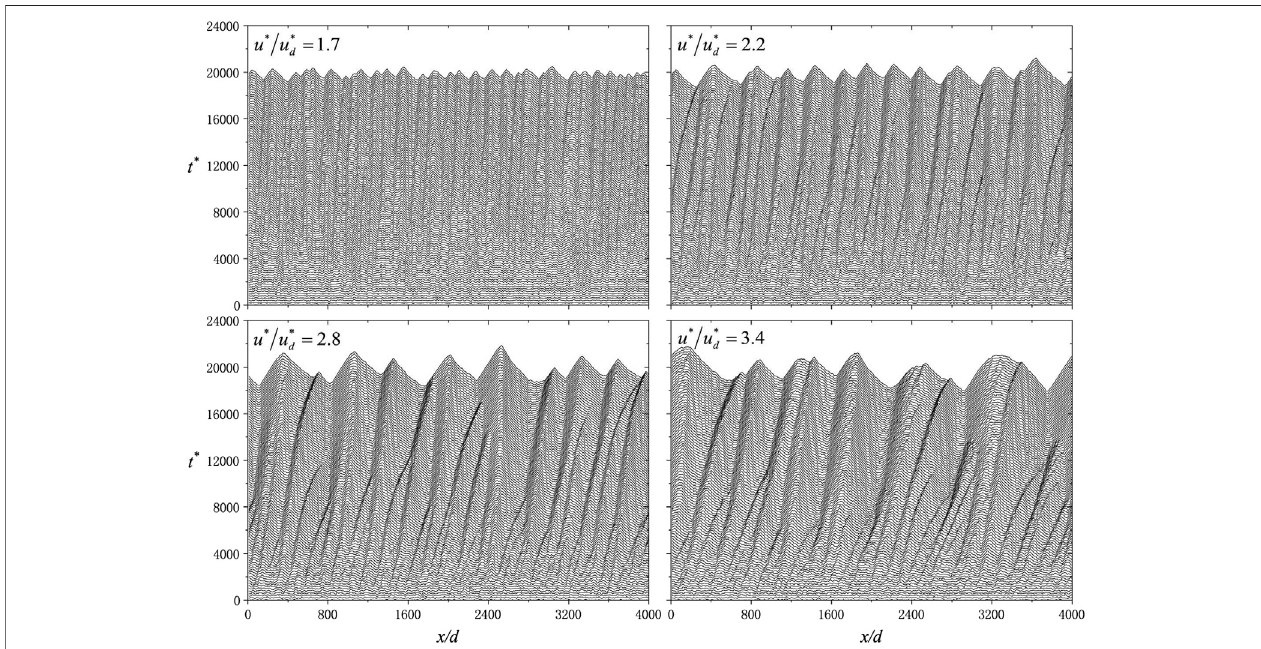
FIGURE 5 | Space-time diagram of sand ripples ’ development at four different wind